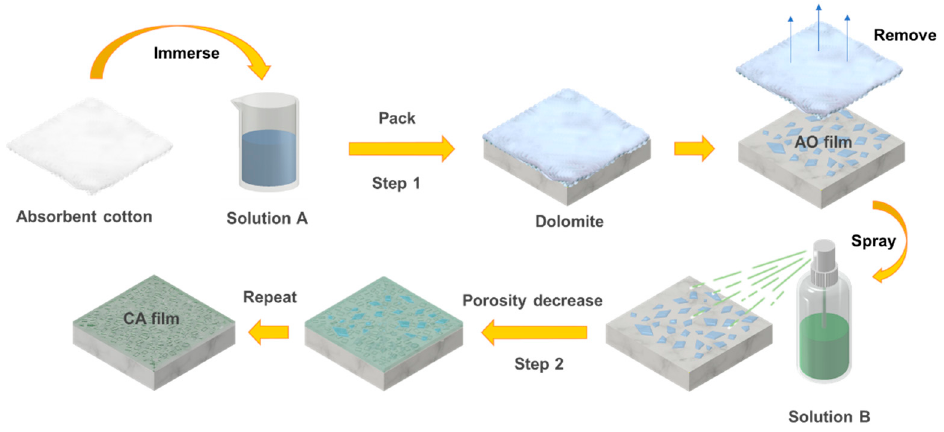
Figure 1. Schematic diagram of the CaC 2 O 4 · H 2 O film deposition by a two-step